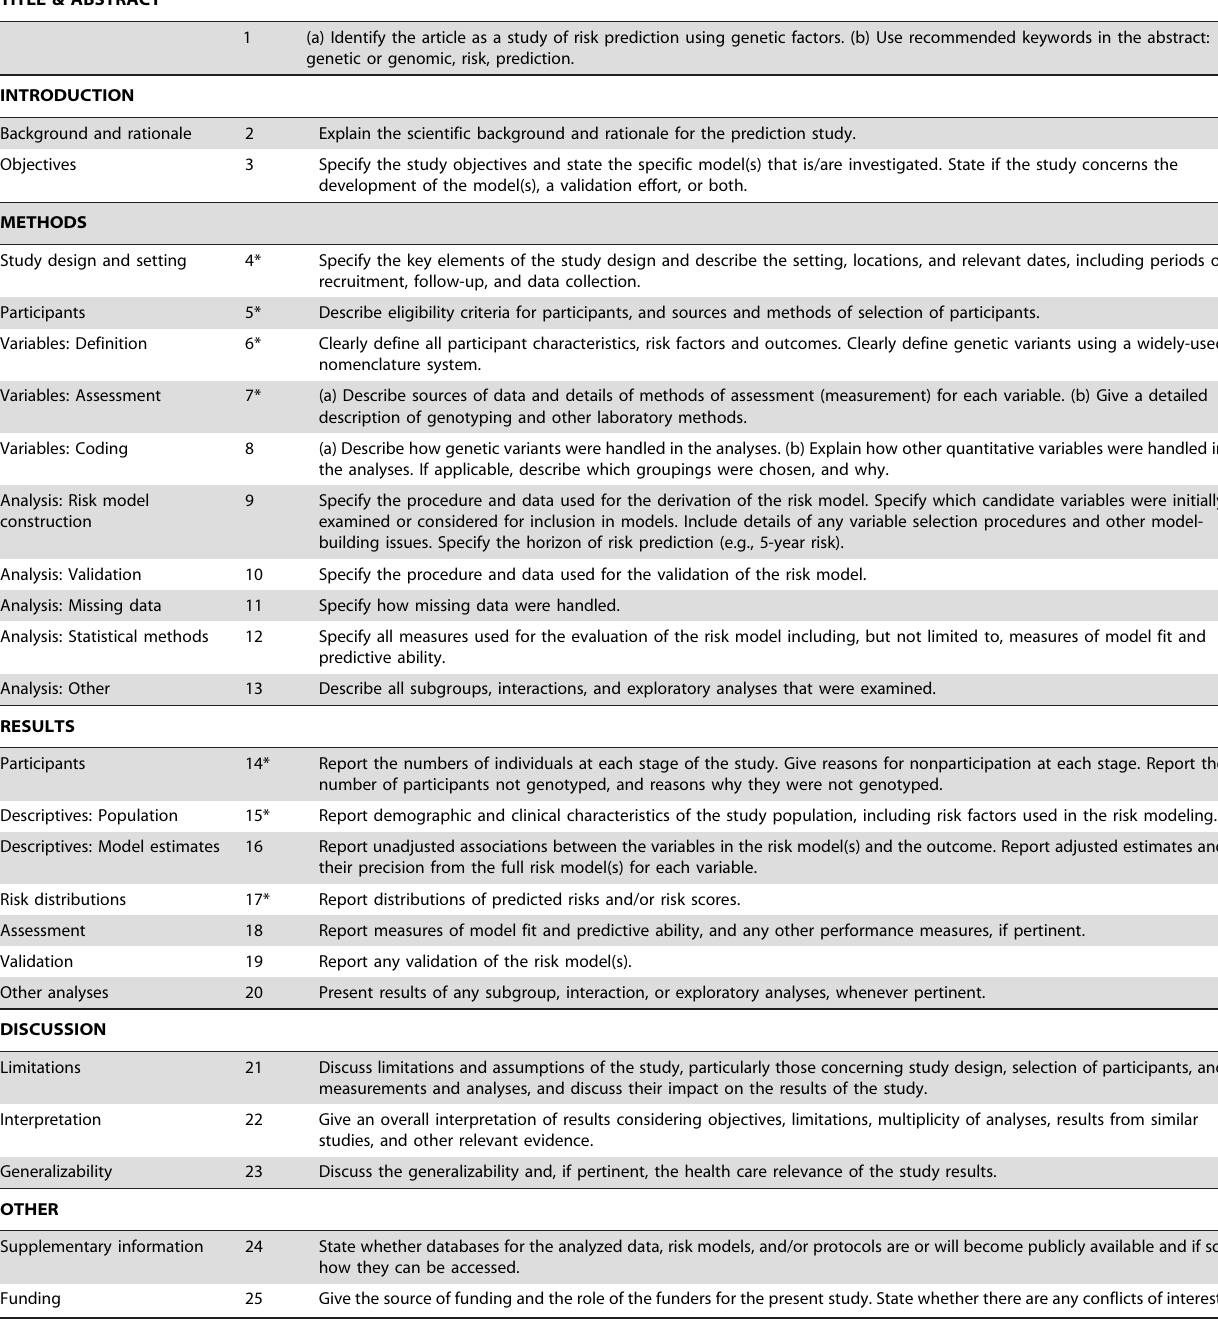
Table 1. Reporting recommendations for evaluations of risk prediction models that include genetic